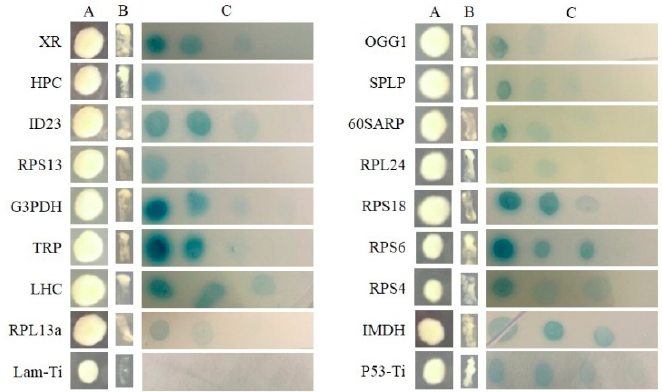
Figure 3. Plasmid linkage assays for BL transformants identified during yeast two-hybrid screening. Transformants containing the bait and prey plasmids were identified based on their growth on dropout medium (SD -Leu-Trp ; column A). Putative interacting partners were identified based on their growth on SD -Leu-Trp-His-Ade (column B), and the interaction strength was detected on SD -Leu-Trp-His-Ade medium with α -x-gal (column C), each drop concentration ranged from 10 − 1 , 10 − 2 , 10 − 3 to 10 − 4 . pGBKT7-53 + pGADT7-Ti was used as positive control, while pGBKT7-Lam + pGADT7-Ti served as negative control.